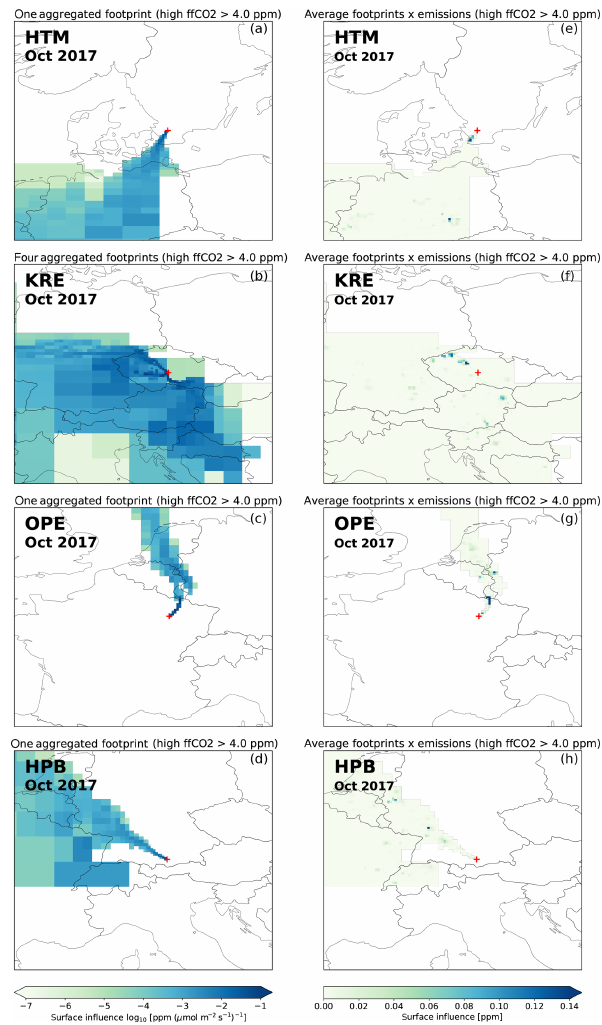
Figure 10. Aggregated footprints with elevated ffCO 2 and the cor- responding surface influences for Hyltemossa (a, e) , Kˇrešín (b, f) , Observatoire Pérenne de l’Environnement (c, g) , and Hohenpeißen- berg (d, h) in October